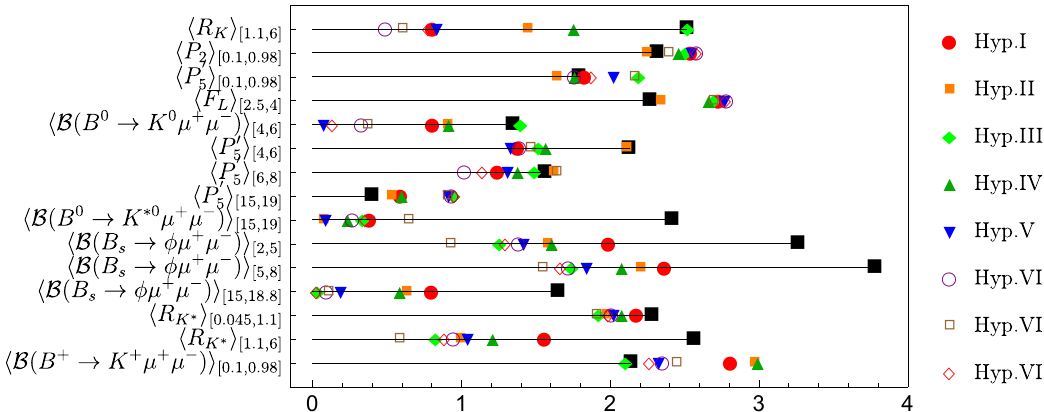
Figure 10. pull obs de(cid:12)ned in eq. (4.1) for each selected observable within di(cid:11)erent NP hypotheses (from I to VIII) compared to the Standard Model (black